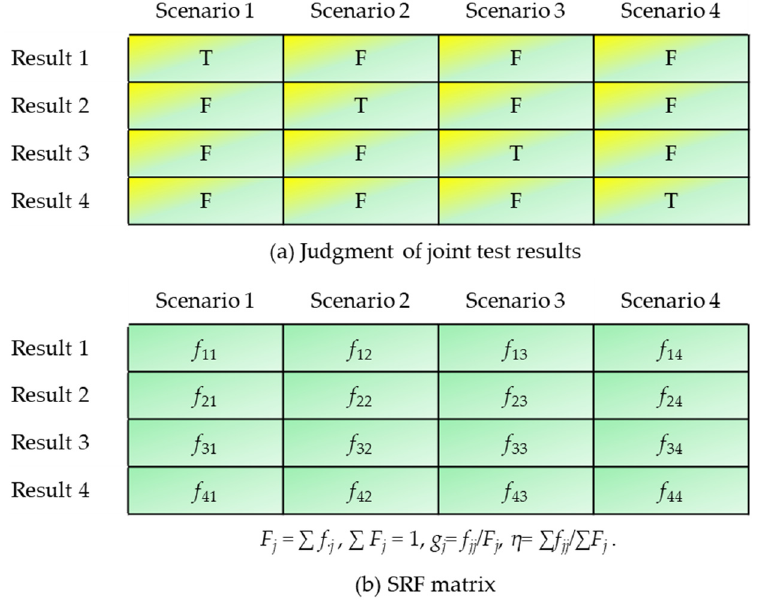
Figure 5. Judgement of trend test results ( a ) and the SRF matrix ( b ). (Note: T and F denote the truthful and false trend test results of the corresponding scenarios, respectively; f ij ( i = 1, . . . , 4; j = 1, . . . , 4) denotes the frequency of Result i corresponding to Scenario j in the simulation experiment 2; F j is the frequency of Scenario j in the simulation experiment 2; g j represents the accuracy rate for Scenario j ; and η is the overall accuracy rate).